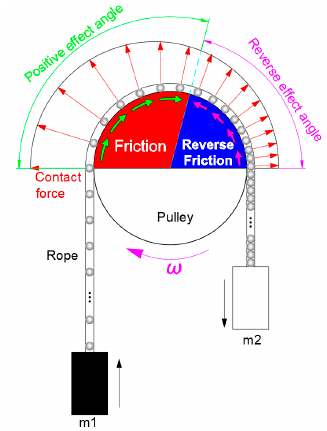
Figure 21. The new friction transmission theory of “global dynamic wrap angle”.